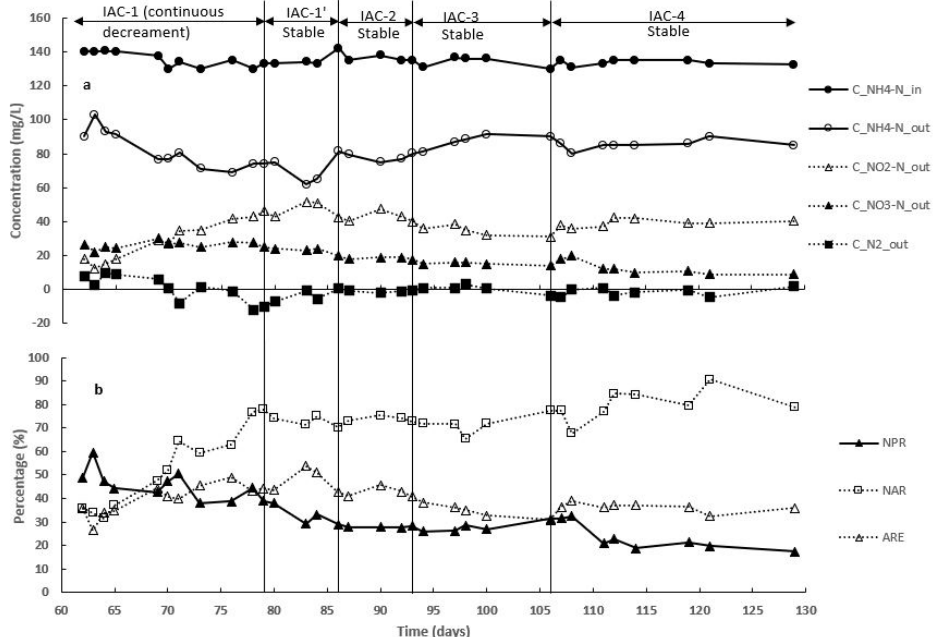
Figure 7. Nitrogen compounds transformation under intermittent aeration: ( a ) Nitrogen compounds variations; ( b ) Nitrogen compounds accumulation and removal efficiency.